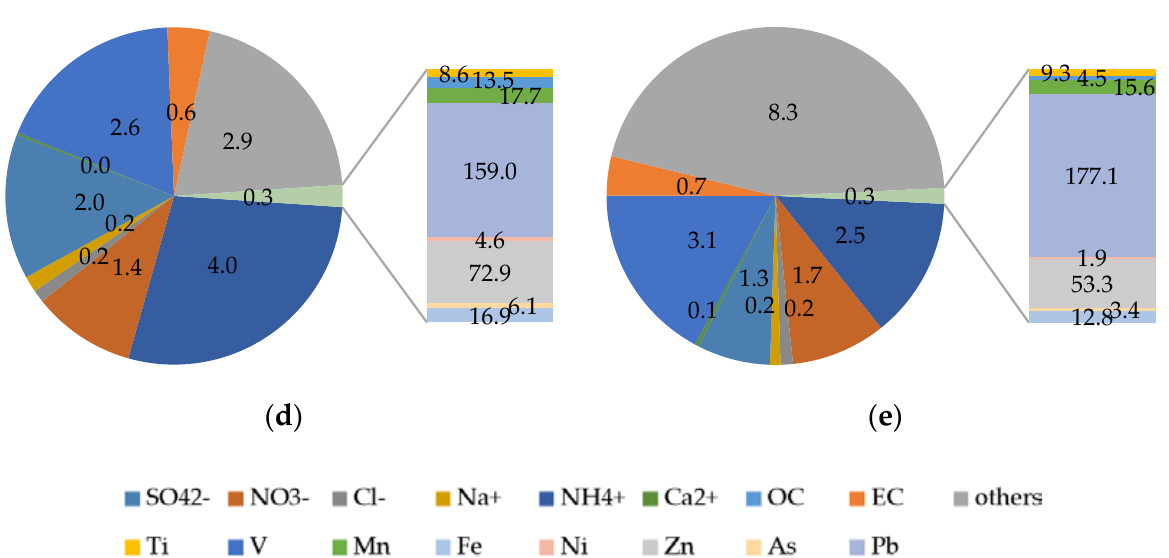
Figure 3. Pie-chart showing the mean concentrations of different components of PM2.5, obtained using hourly data for Ulsan. ( a ) Annual mean; ( b ) mean for winter months; ( c ) mean for spring months; ( d ) mean for summer months; ( e ) mean for fall months. (Units: µg/m 3 for pie-chart, ng/m 3 for vertical chart) (see Table S2 for more detail).